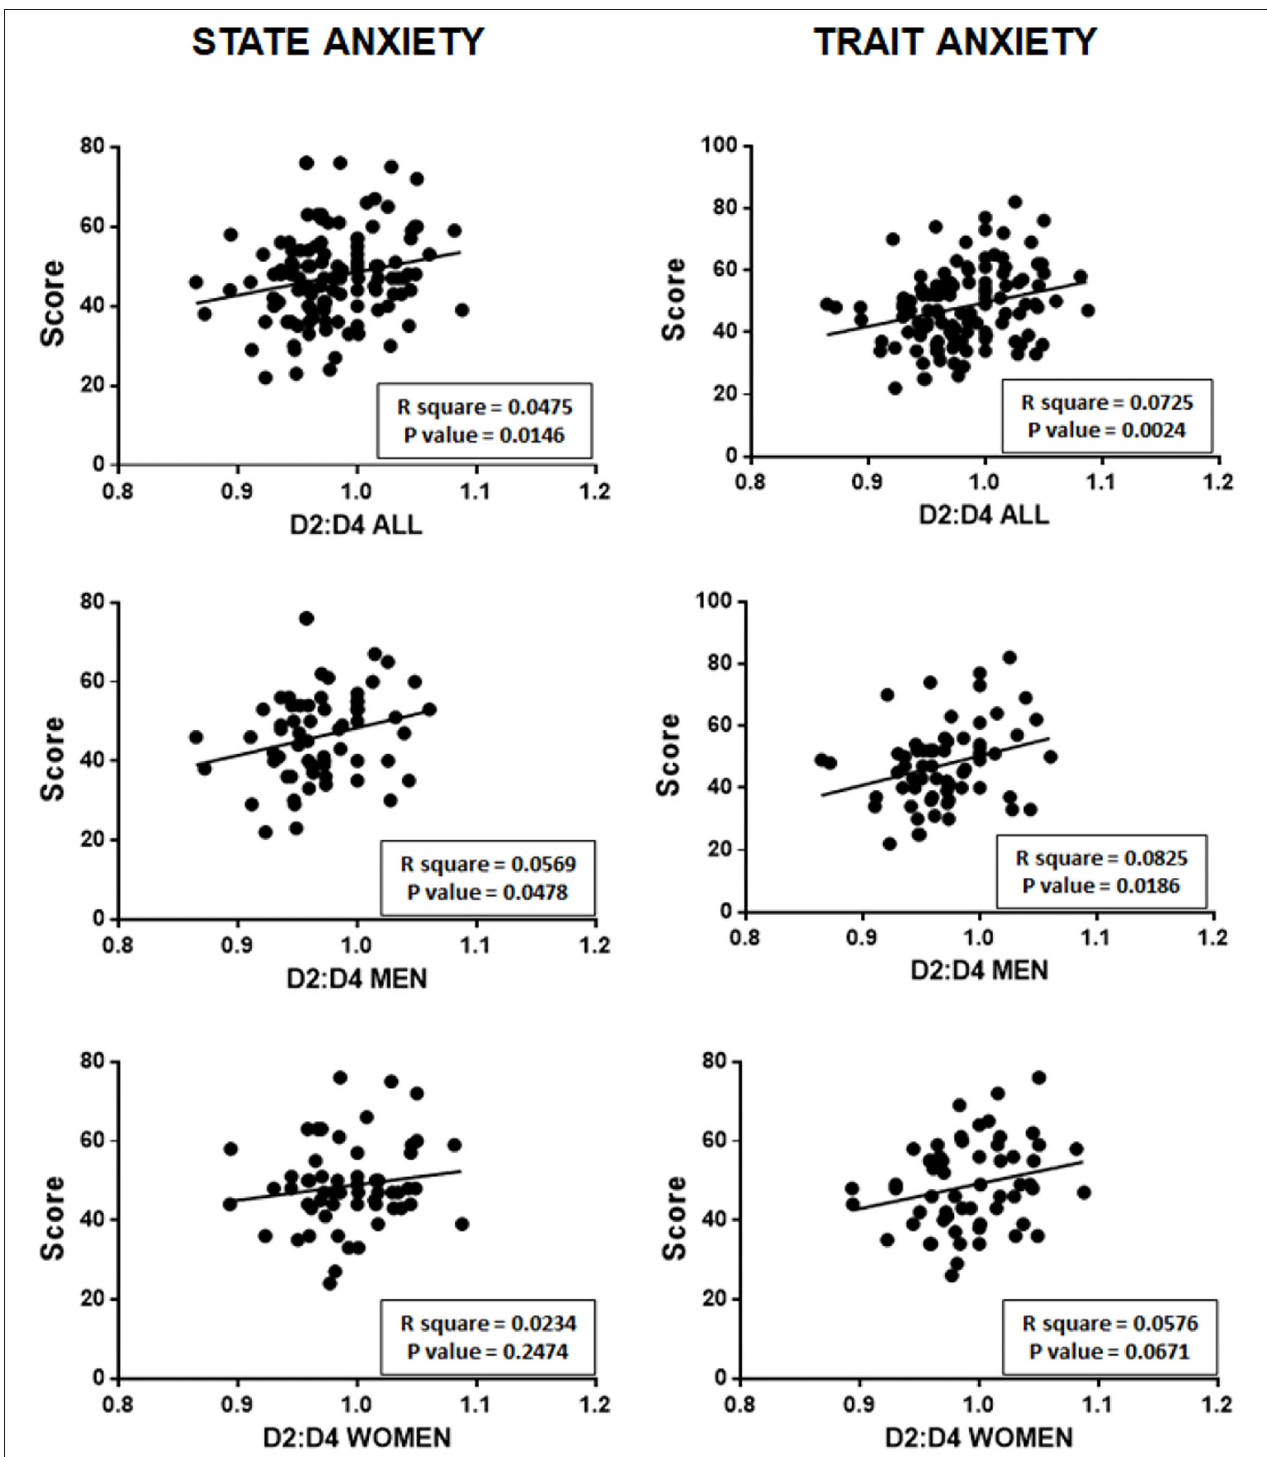
FIGURE 3 | Positive correlations between D2:D4 ratios and state and trait anxiety scores, both of the total sample, and separately for men and women.